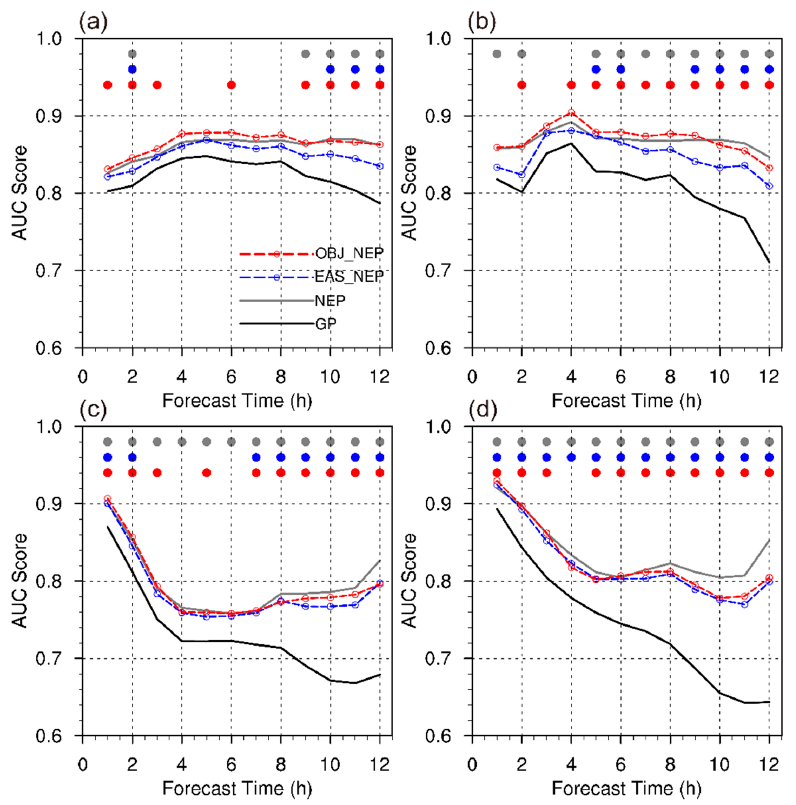
Figure 11. Graphs of area under curve (AUC) scores as a function of forecast lead time for GP (black line), NEP (gray line), EAS_NEP (blue line), and OBJ_NEP (red line) with a precipitation threshold of (left column) 1 mm/h and (right column) 5 mm/h, under ( a,b ) SF and ( c,d ) WF. Solid dots show the 85% bootstrap confidence intervals for differences between each fraction-based method and GP.